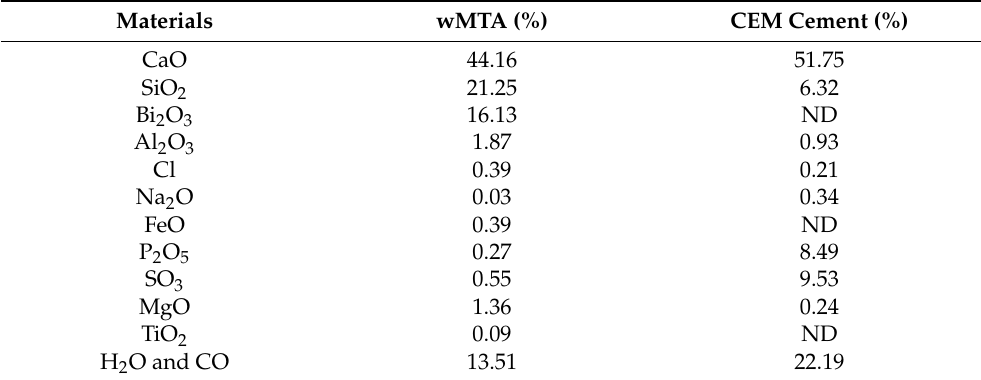
Table 1. Composition of wMTA and CEM